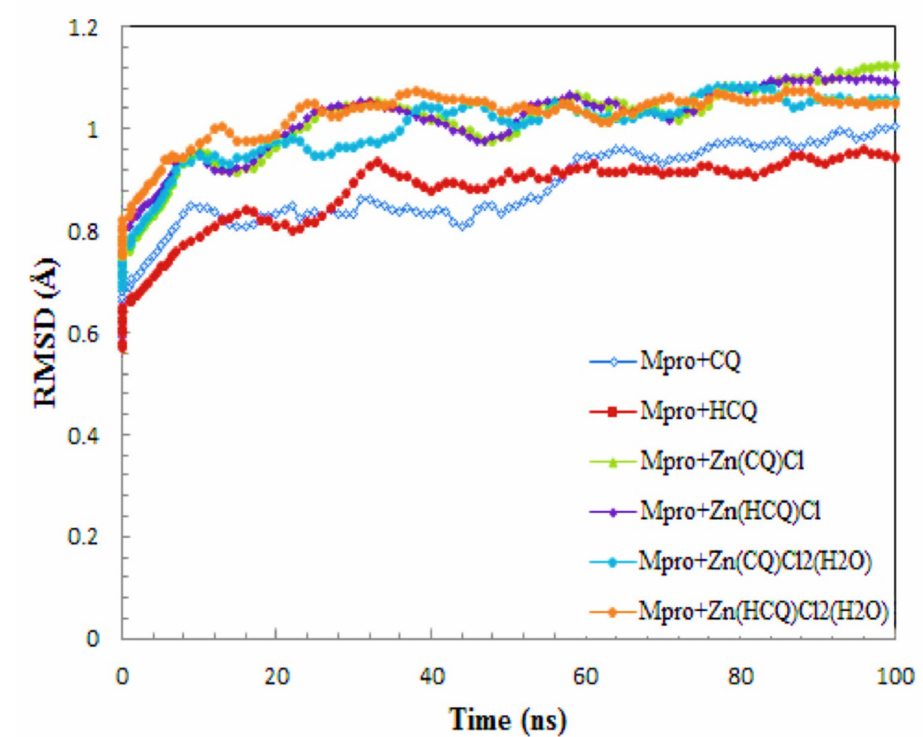
Figure 6. The RMSD charts for Mpro-complexes derived from molecular dynamics simulations. Reprinted/adapted with permission from Ref.